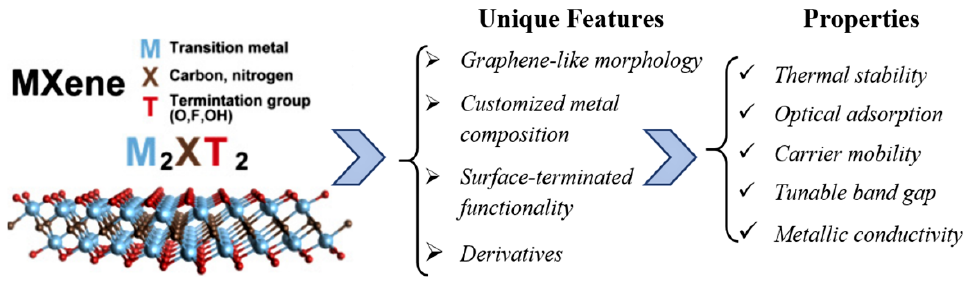
Figure 3. Schematic illustration of features and properties of MXenes. Reprinted with permission from [56]. Copyright © 1969, Elsevier.